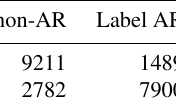
Table B5. Confusion matrix of the method for the testing set – the CAM5.1 data (daily, 100km). It shows the number of correctly recognized (the diagonal) and the number of incorrectly classified events (off-diagonal).